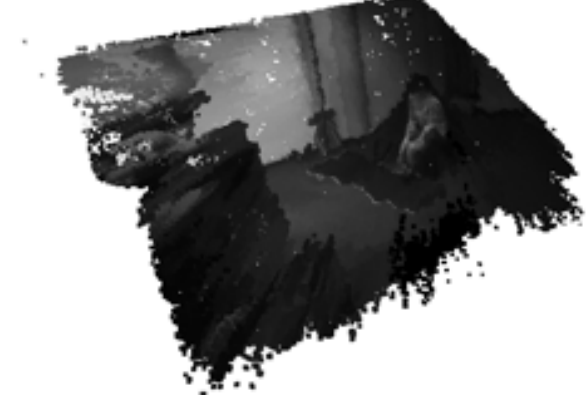
Figure 11: Fused point clouds coming from Hella stereo